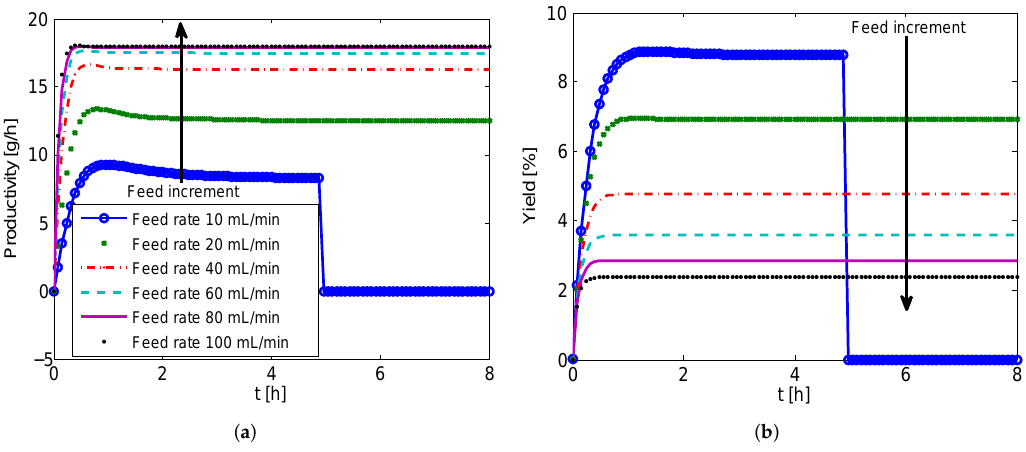
Figure 5. Simulation results showing effect feed flow rate on the productivity and yield for the coupled preferential crystallization in MSMPR crystallizers (CPC-MSMPR) (seed mass 2 g, liquid phase exchange rate 80 mL min − 1 ). ( a ) Increase in feed flow rate up to 80 mL min − 1 causes an increase